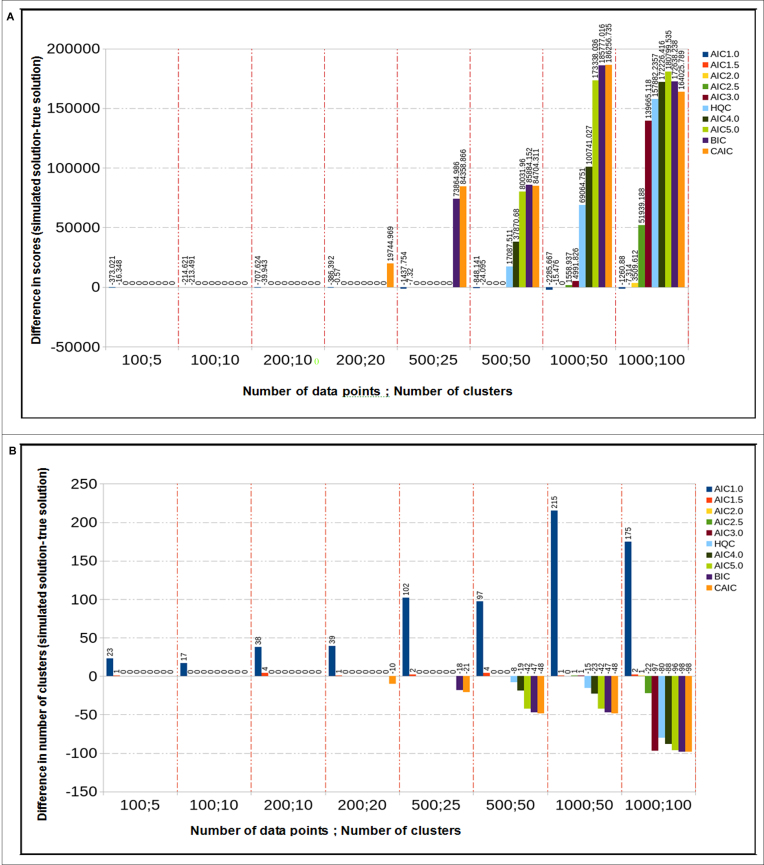
Result from our algorithm using a data set simulated from the probability distribution assumed in the paper for \documentclass[12pt]{minimal}
\usepackage{amsmath}
\usepackage{wasysym}
\usepackage{amsfonts}
\usepackage{amssymb}
\usepackage{amsbsy}
\usepackage{upgreek}
\usepackage{mathrsfs}
\setlength{\oddsidemargin}{-69pt}
\begin{document}
}{}${n_r} = 20$\end{document} binary variables and \documentclass[12pt]{minimal}
\usepackage{amsmath}
\usepackage{wasysym}
\usepackage{amsfonts}
\usepackage{amssymb}
\usepackage{amsbsy}
\usepackage{upgreek}
\usepackage{mathrsfs}
\setlength{\oddsidemargin}{-69pt}
\begin{document}
}{}${n_e} = 20$\end{document} continuous variables. In this case, parameters of the simulation correspond to tightly clustered data and relatively little ‘noise’ (Bernoulli parameters of 0.1 or 0.9 at each regulatory input and expression standard deviations of 0.01). Cases simulated covered 100–1000 data points and 10 or 20 data points per cluster in each case. Panel (A) shows the difference in score, and panel (B) the difference in the number of clusters, between the solutions found by the algorithm and the known true solutions. Results are shown for several objective functions arranged in order of increasing penalty value λ. Differences of zero in each case indicate that the algorithm found the true solution; negative score differences indicate objective function failures (solutions different to the true solution exist with better scores), and positive score differences indicate search algorithm failure (algorithm stopped at a solution scoring worse than the true solution).